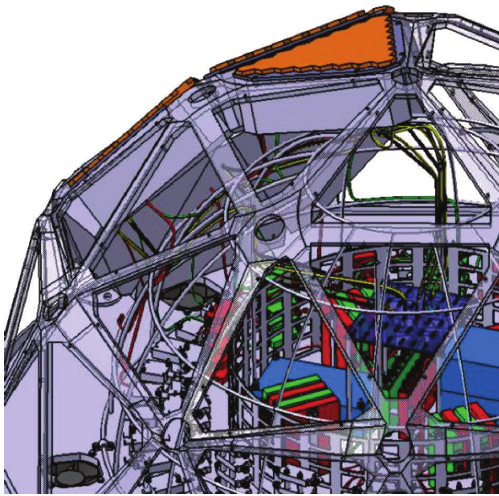
Figure 15: Cable routing of a part of the